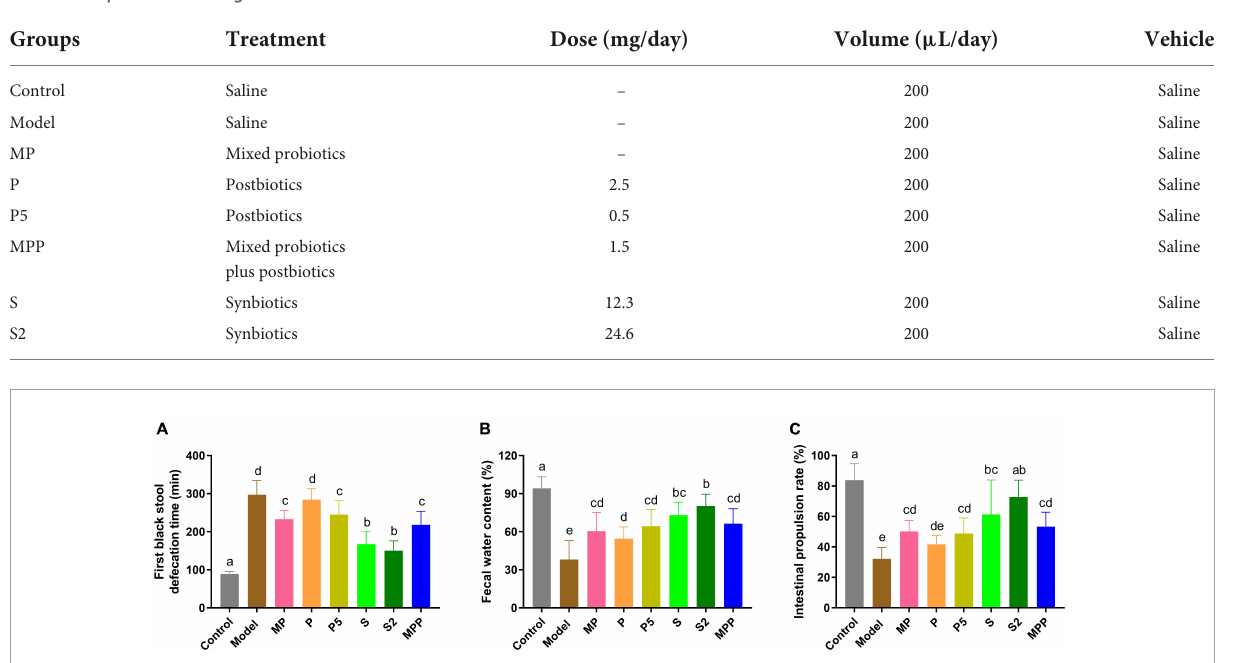
TABLE 1 Experimental design of the animal trail.